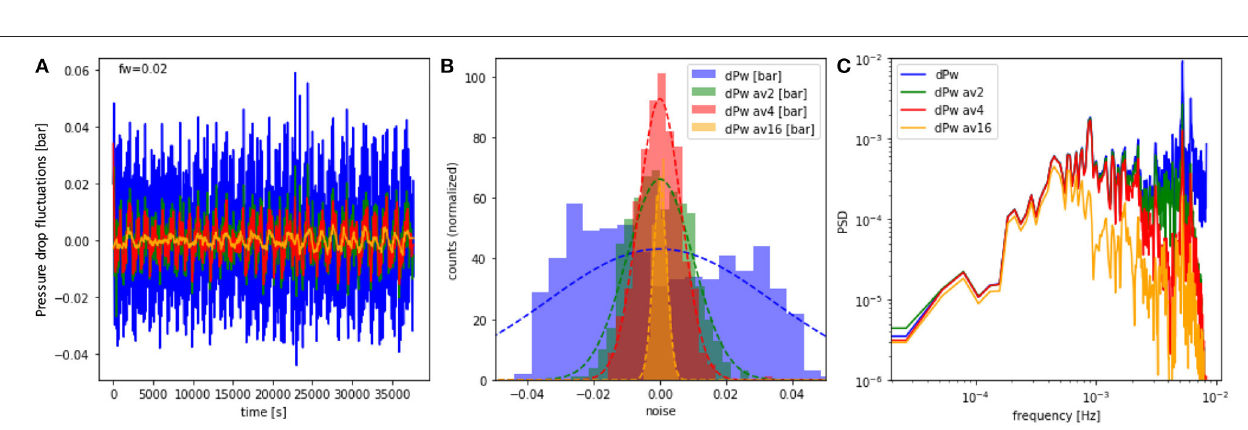
FIGURE 3 | Pressure drop dp and saturation S w fluctuation ( S w fluctuations were magnified by factor 5 for better visibility) from Figure 2 for fractional flows 1.0 ≥ f w ≥ 0.75 showing an almost perfectly Gaussian behavior (dotted lines represent a Gaussian fit to the respective data). For dp the correlation coefficient R 2 is 0.94–0.96. For S w the correlation coefficient ranges between 0.41 and 0.69, which is likely because of the lower signal-to-noise of the S w data.